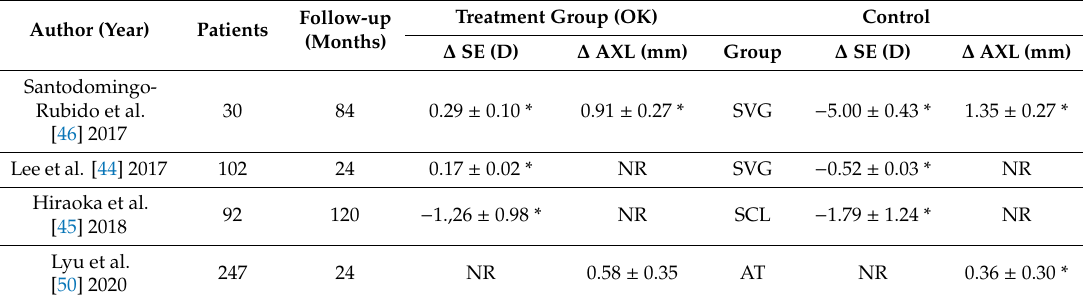
Table 2. Study characteristics and results summary of orthokeratology myopia